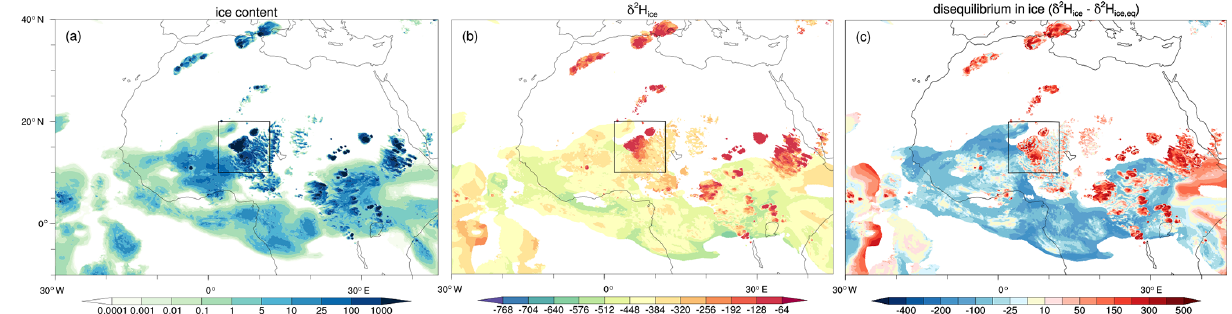
Figure 5. Spatial distribution of ice and its isotopic composition at 200hPa at 18:00UTC on 15 June 2016 for the (a) ice content (mgkg − 1 ), (b) δ 2 H in ice (‰), and (c) disequilibrium in ice (‰); see the text for details. Variables in all panels are transparent when the ice content values are below 10 − 4 mgkg − 1